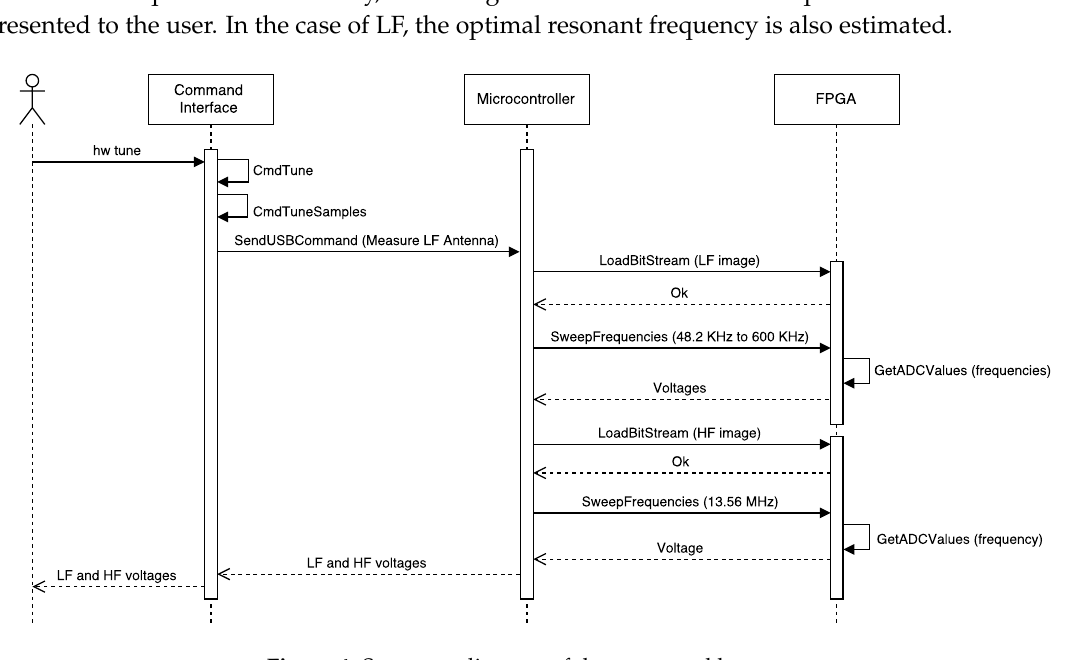
Figure 4. Sequence diagram of the command hw